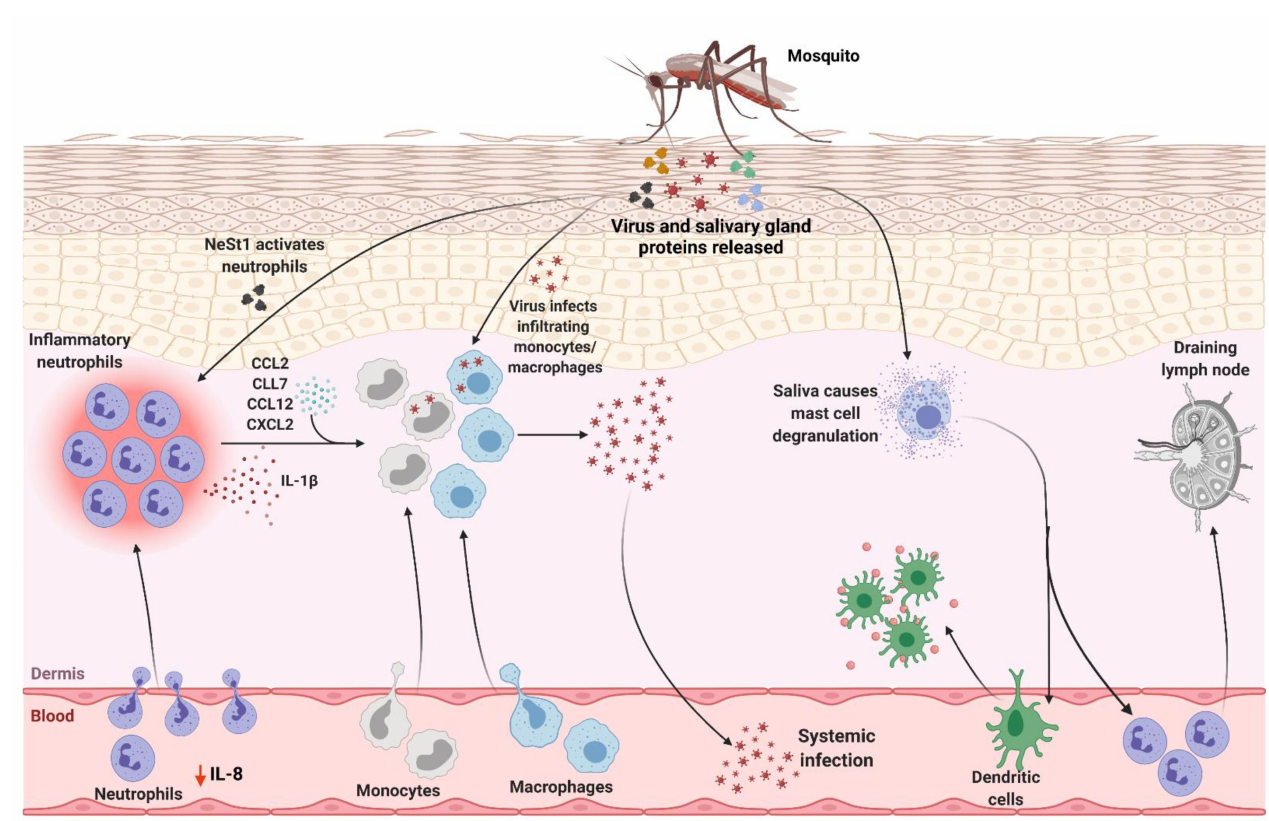
Figure 1. Neutrophil-mediated viral replication and dissemination induced by mosquito saliva. During a blood meal, mosquito carrying an arbovirus injects the virus along with its salivary gland proteins below the skin of the host. There is a decrease in IL-8 levels in the serum correlating to lower number of circulating neutrophils and higher number in the skin. One of the proteins in the saliva, neutrophil-stimulating factor 1 (NeSt1), activates the neutrophils in the dermis, the deepest layer of the skin, which houses the immune cells. IL-1 β is secreted by these inflammatory neutrophils to establish cutaneous response to the bite. Additionally, bite-associated monocyte/macrophage-attracting chemokines, CCL2, CCL7, CCL12, and CXCL2, are upregulated. The infiltrating monocytes and macrophages are permissive to infection enhancing viral replication and increasing the potential for systemic spread. The mosquito saliva also causes vascular permeabilization and mast cell degranulation in the skin recruiting dendritic cells to the bite site, contributing to the inflammation, and neutrophils to the draining lymph